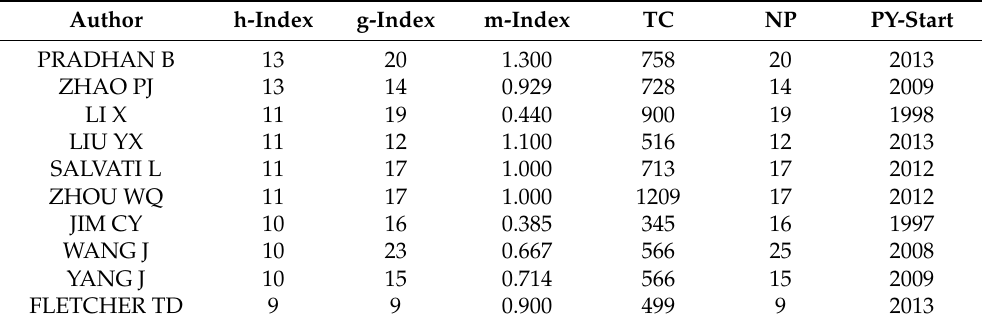
Table 3. The 10 most influential authors in the field of urban land management in Web of Science from 1979 to